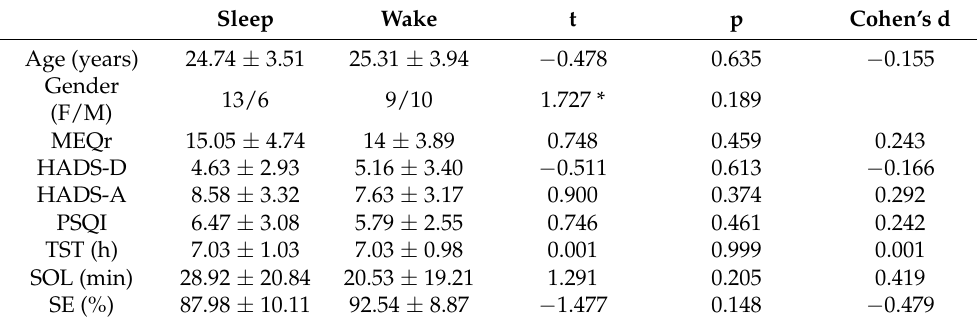
Table 1. Mean ± standard deviation of self-report questionnaires in the two